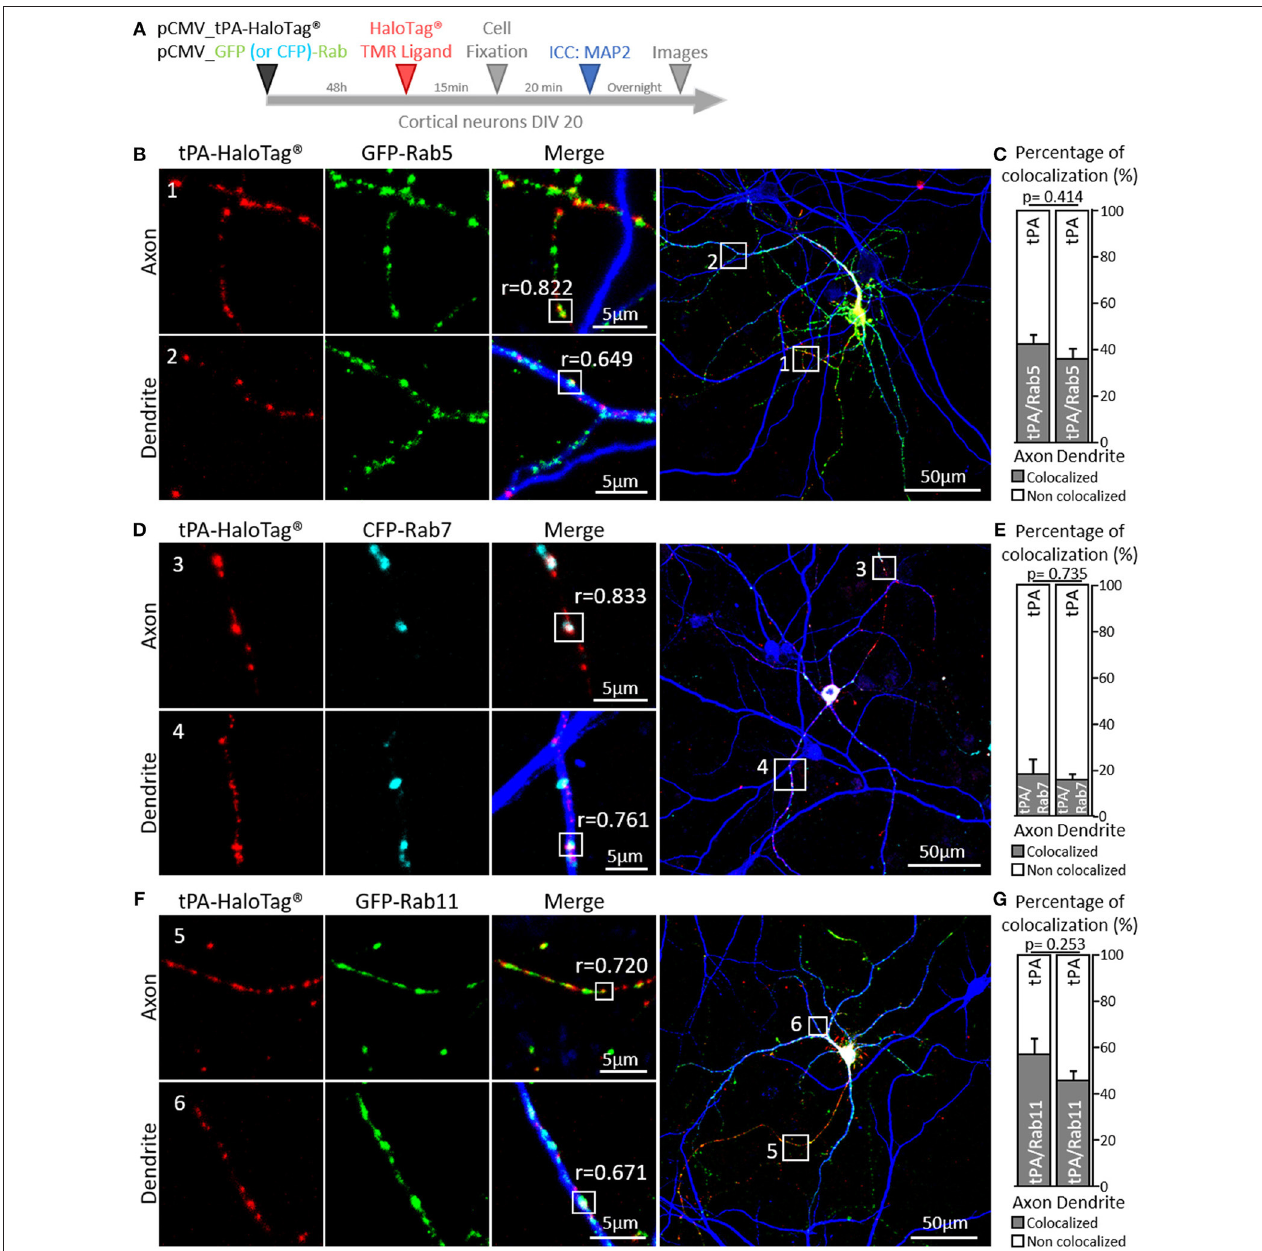
FIGURE 7 | tPA is associated with Rabs proteins. (A) Timeline of experiments. (B) Representative z-stack images of co-transfected cortical neurons (DIV20) with pCMV_tPA-HaloTag ® (TMR ligand, in red) and pCMV_GFP-Rab5 (in green), followed by ICCs raised against MAP2 (in blue). tPA-HaloTag ® colocalizes with GFP-Rab5 (early endosome) in axons (MAP2–; frame 1) and in dendrites (MAP2 + ; frame 2) with Pearson’s coefficients respectively, of r = 0.822 and r = 0.649. (C) Representative diagrams of the percentages of colocalization between tPA-HaloTag ® and GFP-Rab5 in function of total tPA-HaloTag ® puncta. There are 42% of colocalization in axons and 36% in dendrites ( N = 3 and N = 8 neurons respectively, from 4 independent cultures, p = 0.414). (D) Representative images of co-transfected cortical neurons (at DIV20) with pCMV_tPA-HaloTag ® (reveals by TMR ligand, in red) and pCMV_CFP-Rab7 (in cyan), followed by ICCs raised against MAP2 (in blue). tPA-HaloTag ® colocalizes with CFP-Rab7 (late endosome and lysosome degradation) in axons (MAP2–; frame 3) and in dendrites (MAP2 + ; frame 4) with Pearson’s coefficients respectively of r = 0.833 and r = 0.761). (E) Representative diagrams of the percentages of colocalization between tPA-HaloTag ® and CFP-Rab7 in function of total tPA-HaloTag ® puncta. There are 18% of colocalization in axons and 16% in dendrites ( N = 3 and N = 10 neurons respectively, from 4 independent cultures and p = 0.735). (F) Representative z-stack images of co-transfected cortical neurons (at DIV 20) with pCMV_tPA-HaloTag ® (TMR ligand, in red) and pCMV_GFP-Rab11 (in green), followed by ICCs raised against MAP2 (in blue). tPA-HaloTag ® colocalizes with GFP-Rab11 (recycling endosome) in axons (MAP2–; frame 5) and in dendrites (MAP2 + ; frame 6) with Pearson’s coefficients respectively, of r = 0.720 and r = 0.671. (G) Representative diagrams of the percentages of colocalization between tPA-HaloTag ® and GFP-Rab11 in function of total tPA-HaloTag ® puncta. There are 57% of colocalization in axons and 46% in dendrites ( N = 6 and N = 7 neurons respectively, from 2 independent cultures and p = 0.253). For all images: scale Bar: 5 or 50 µ m (whole